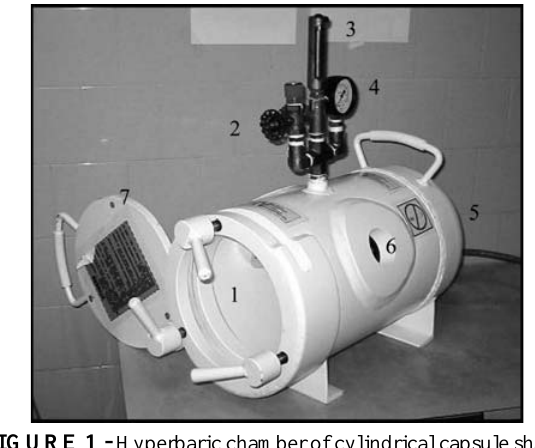
FIGURE 1 - Hyperbaric chamber of cylindrical capsule shape built from carbon steel. 1- Entrance and outlet of the chamber; 2- Oxygen escape valve; 3- Thermometer; 4- Manometer; 5- Tube for oxygen entrance into the chamber; 6- Viewer for the observation of animals within the chamber; 7- Chamber occlusion lid. The chamber is 27 cm wide, 25 cm long and 1,5 cm